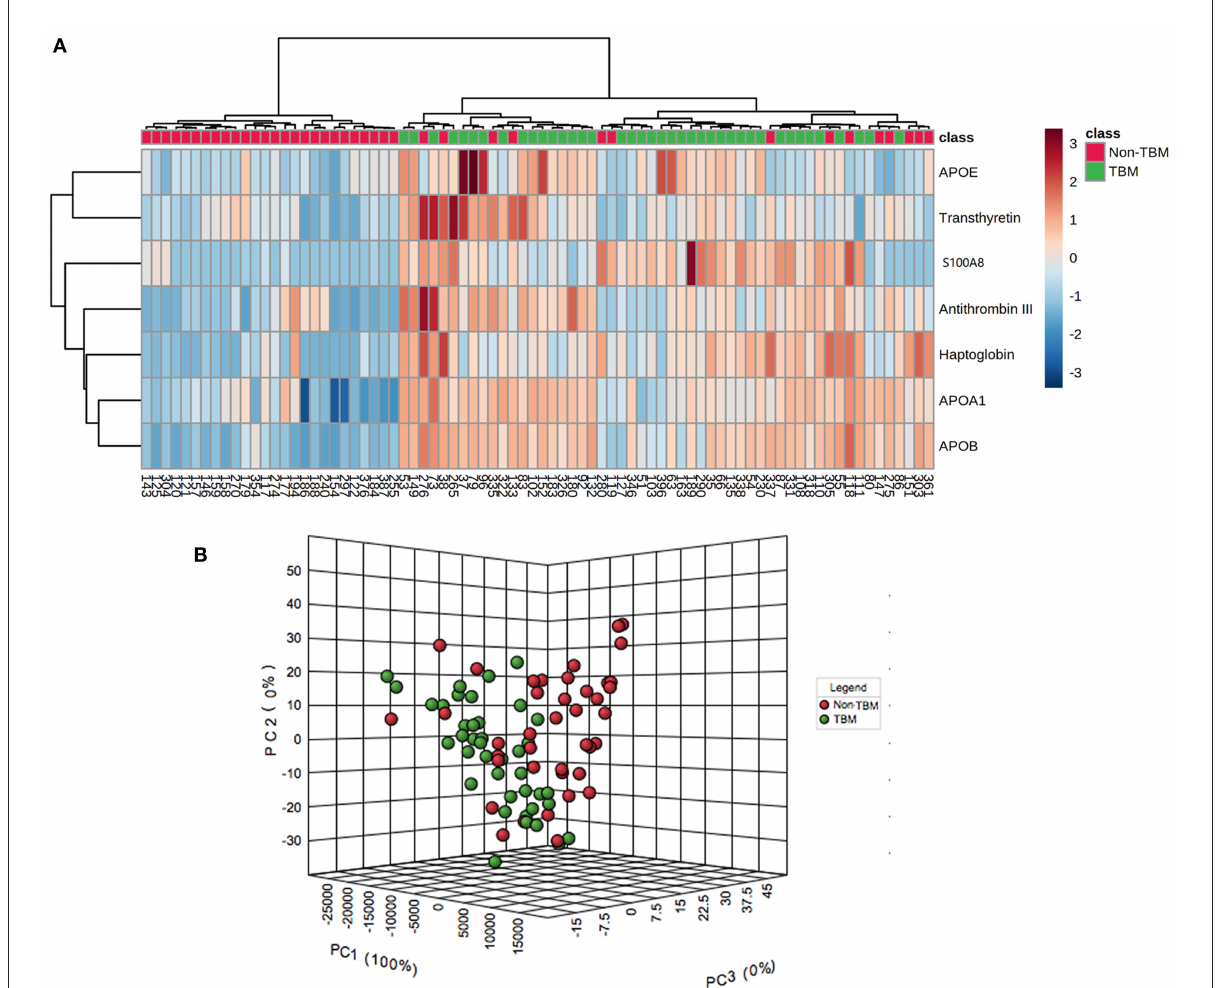
FIGURE4 Unsupervised hierarchical clustering and principal component analyses of differentially expressed proteins in the CSF between patients with TBM and non-TBM. (A) Two-dimensional unsupervised hierarchical clustering of proteins in CSF between patients with TBM and non-TBM. The normalized values for each protein are depicted in accordance with the color scale, where red and blue represent upregulation and downregulation, respectively. (B) Three-dimensional representation of principal component analysis (PCA) of patients with and without TBM. Each dot represents 1 participant based on the values of all proteins studied. Green and red represent patients with TBM and non-TBM, respectively. TBM, tuberculous meningitis; CSF, cerebrospinal